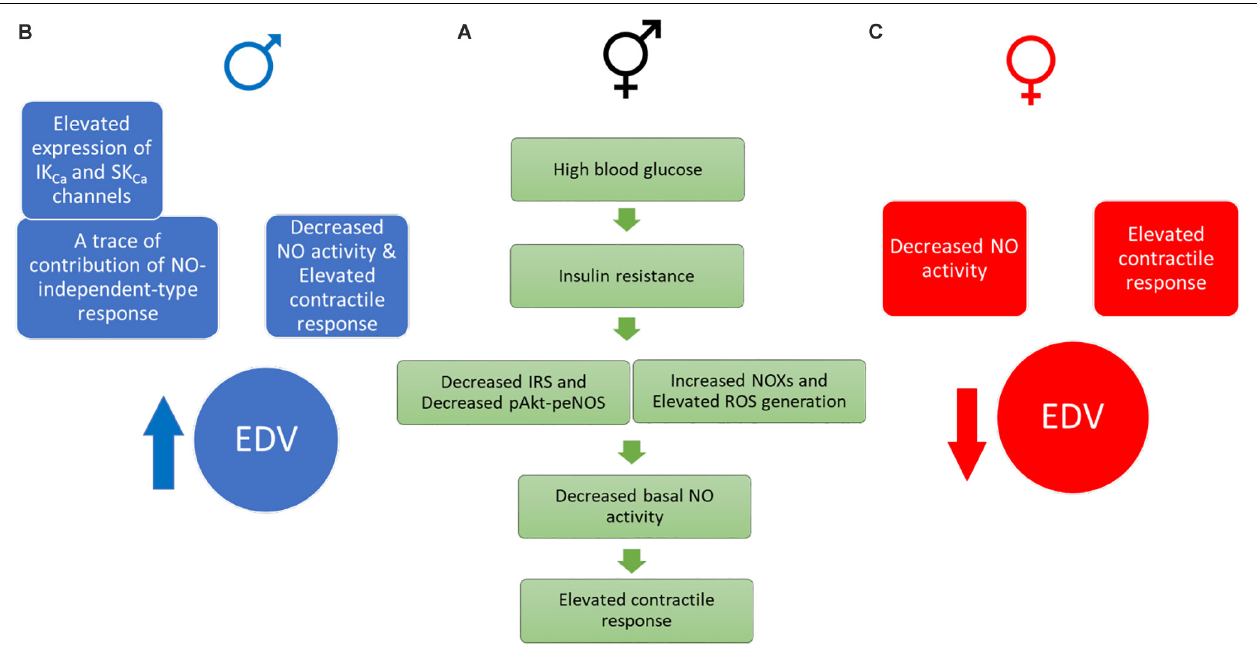
FIGURE 10 | Proposed drivers of an elevated contractile response in UCD-T2DM rat aortas. ( A green one) Impaired insulin signaling, elevated ROS generation, and decreased basal NO activity may drive elevated contractile responses in aortic rings of both male and female UCD-T2DM rats. ( B blue one) Male UCD-T2DM rat aortas display enhanced EDV (despite elevated contractile responses) along with elevated IK Ca and SK Ca channel expression and traces of NO-independent responses. ( C red one) Female UCD-T2DM rat aortas display impaired EDV, possibly due to decreased NO activity and enhanced contractile responses. IRS, insulin receptor substrate; pAkt, phosphorylated V-Akt murine thymoma viral oncogene homolog-2; peNOS, phosphorylated endothelial nitric oxide synthase; NOX, NADPH oxidase; ROS, reactive oxygen species; NO, nitric oxide; IKCa, intermediate-conductance calcium- activated potassium channel; SKca, small-conductance calcium-activated potassium channel; EDV, endothelium-dependent